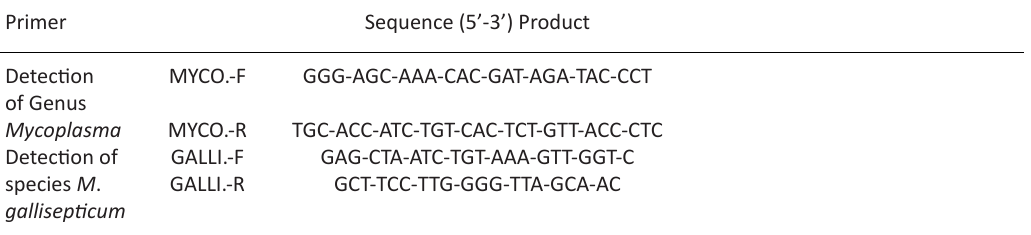
Table 2. PCR thermocycler program for detection of Genus Mycoplasma and species M. gallisepticum Cycle Temp.°C for Temp. °C for M.